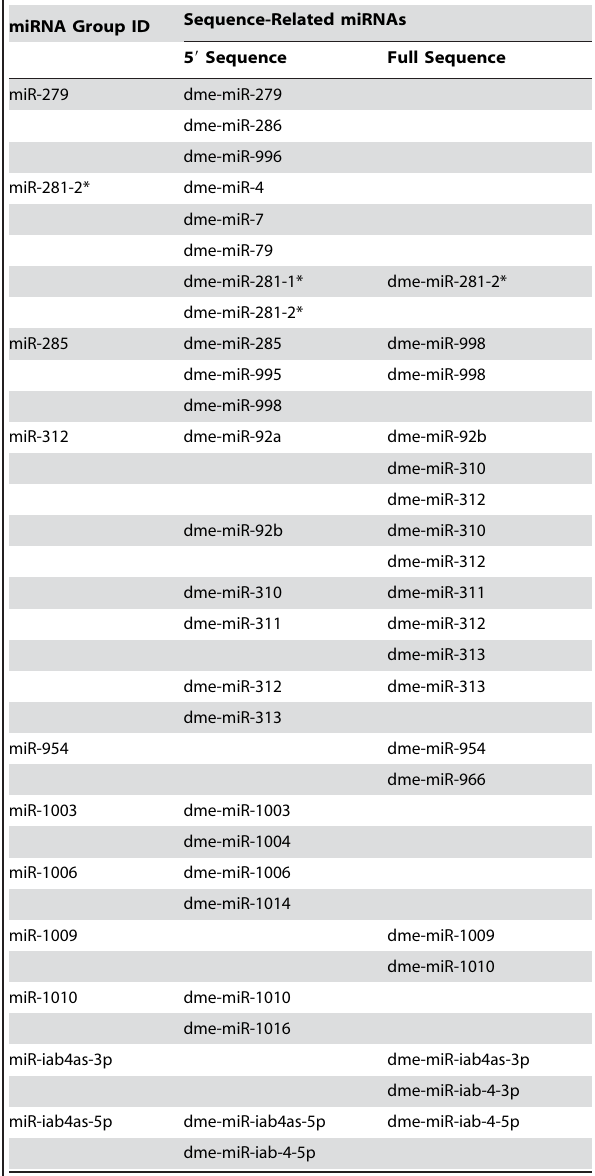
Table 2. Summary of D. melanogaster miRNA relationships.